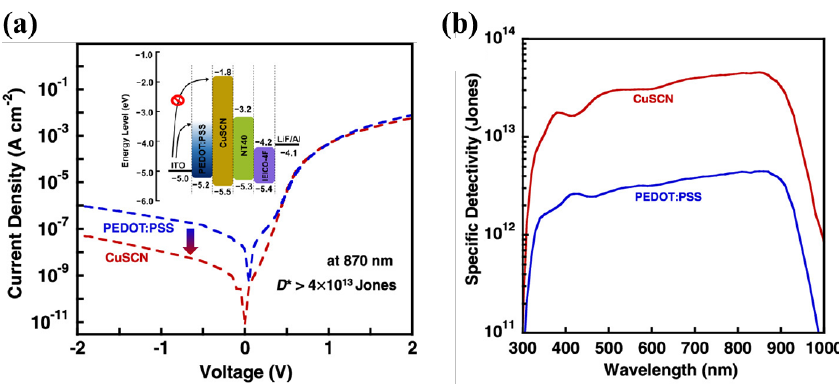
Figure 19. ( a ) Current density versus voltage characteristics of the devices under dark levels of the materials; ( b ) D* curves of photodiodes with CuSCN or PEDOT:PSS interfaces at − 0.1 V. and energy levels of the materials; ( b ) D* curves of photodiodes with CuSCN or (Reproduced with permission from [21]. ACS Publishing, PEDOT:PSS interfaces at −0.1 V. (Reproduced with permission from [21]. ACS Publishing, 2021).